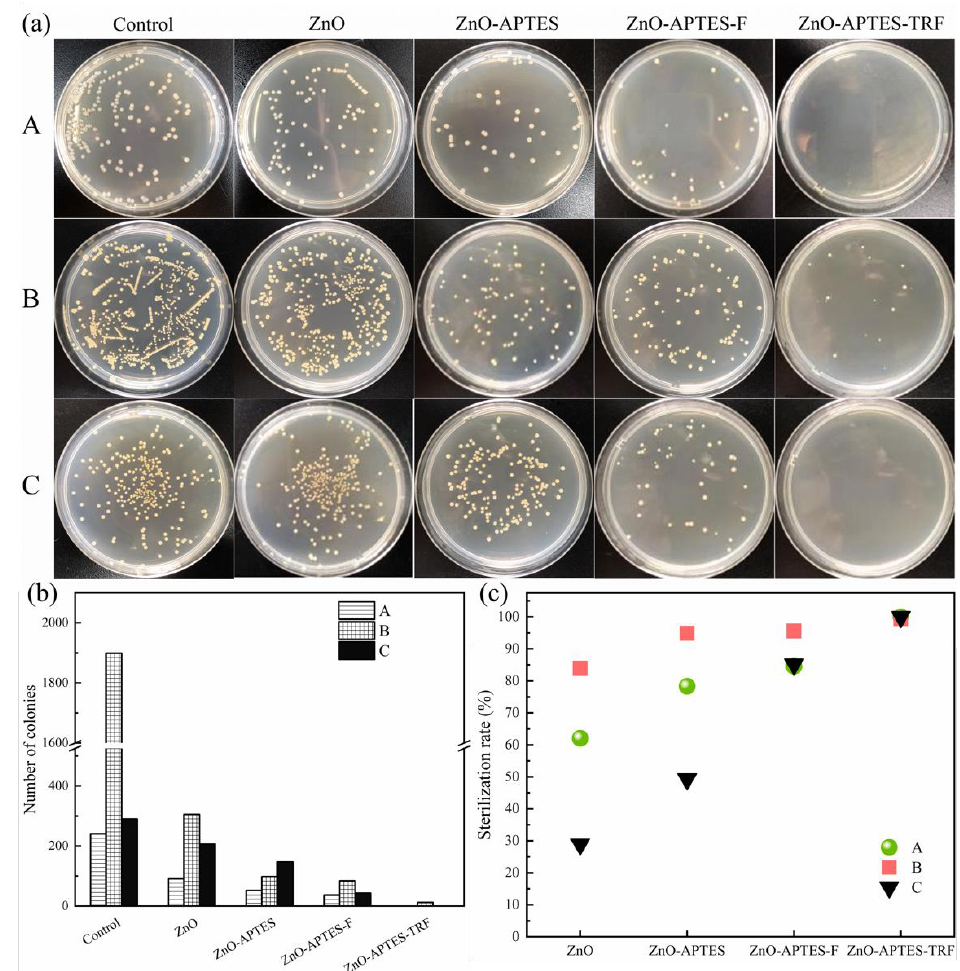
Figure 6. ( a ) Plate counting experiment of three kinds of bacteria. A: Escherichia coli ; B: Staphylococcus aureus ; C: Pseudoalteromonas sp . ; ( b ) Column chart of colony number; ( c ) Sterilization rate.